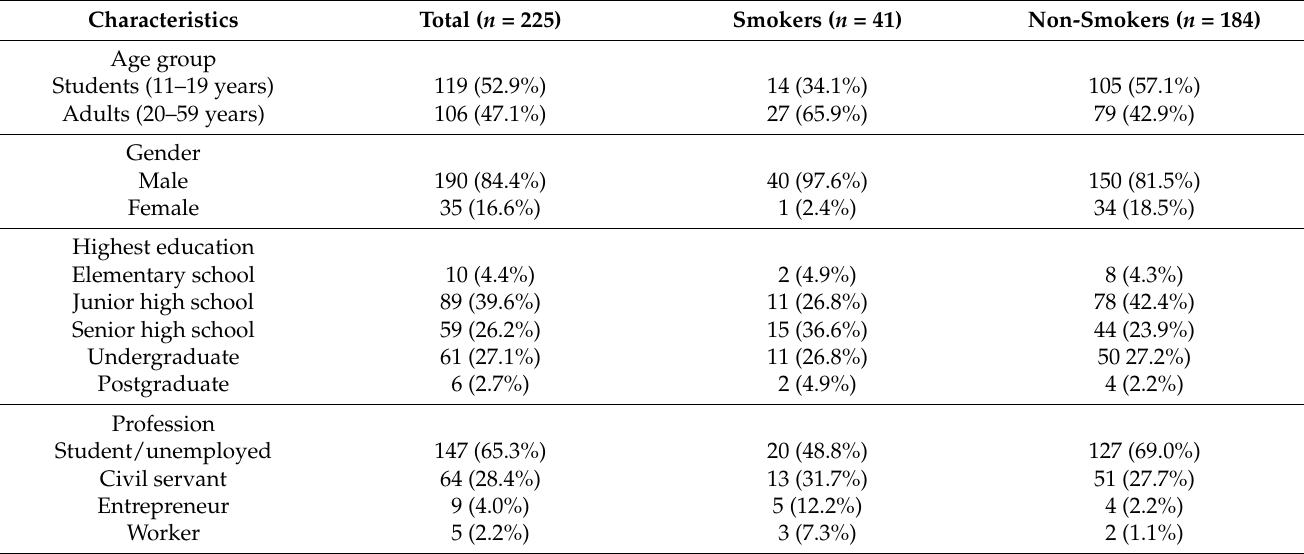
Table 1. Description of the participants of the survey.